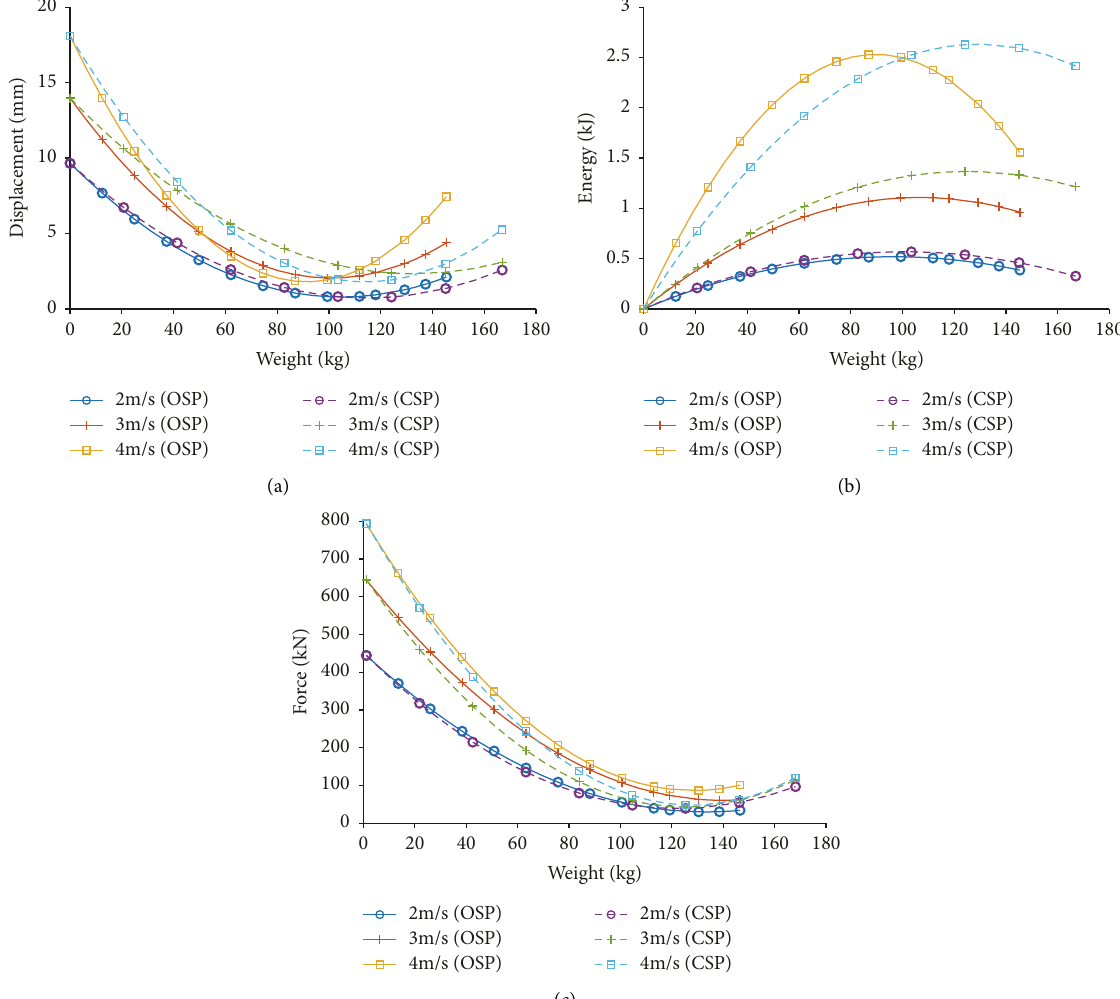
Figure 10: Influence curves of specimen weight. (a) Lateral displacement peak value of the top of the column. (b) Total energy peak value of the CSP/OSP specimen. (c) Lateral impact force peak